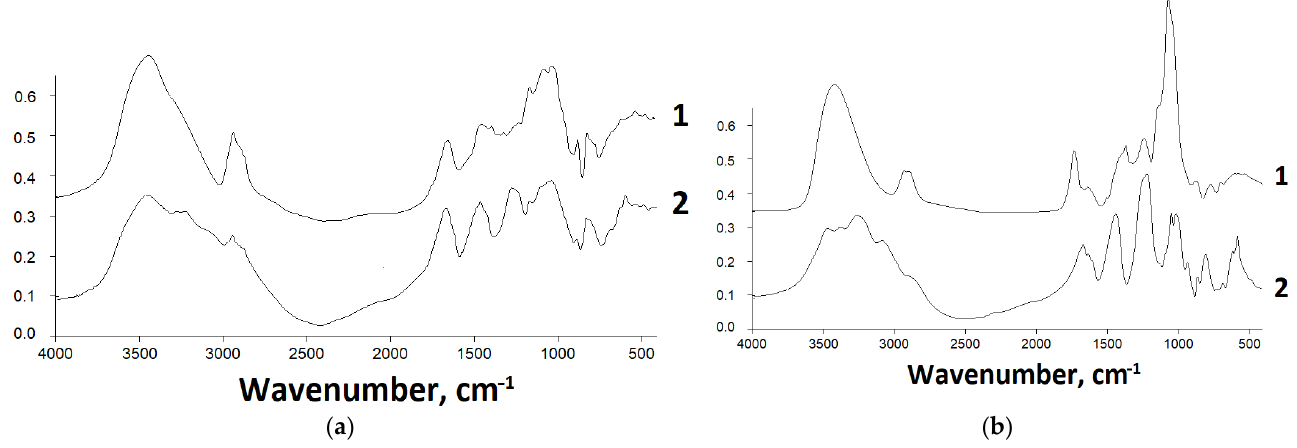
Figure 1. IR spectra for ( a ) GM and ( b ) GGM ((1) initial and (2) sulfated).